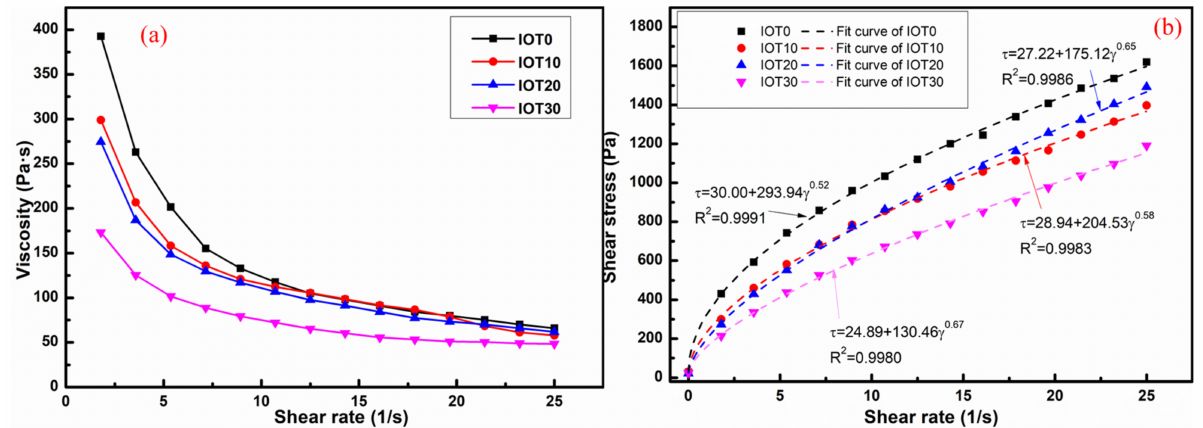
Figure 6. Effect of iron ore tailing on the rheology behavior of designed UHPC: ( a ) Viscosity; ( b ) shear stress.